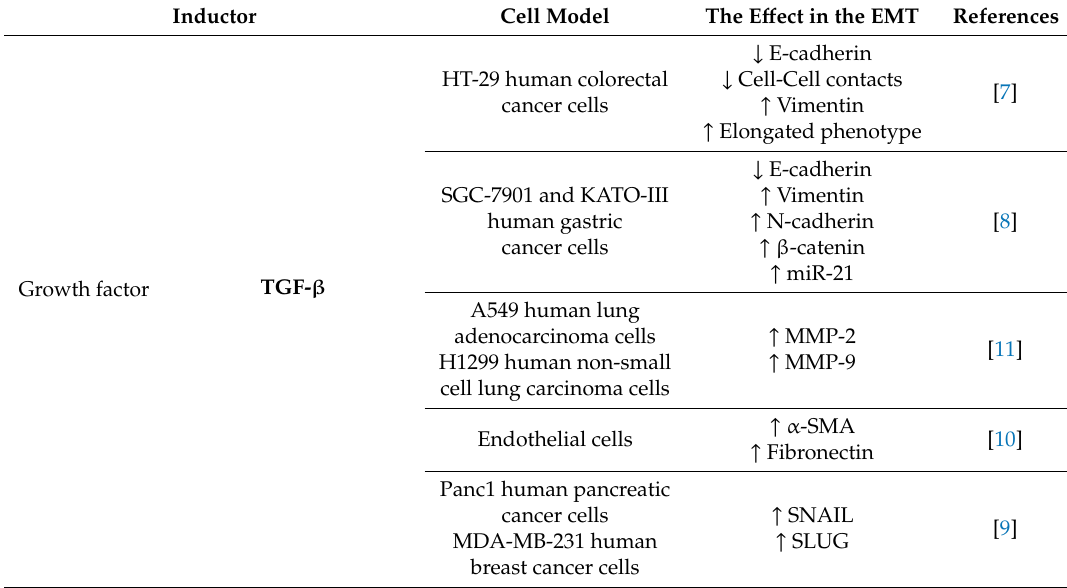
Table 1. Epithelial-mesenchymal transition (EMT)